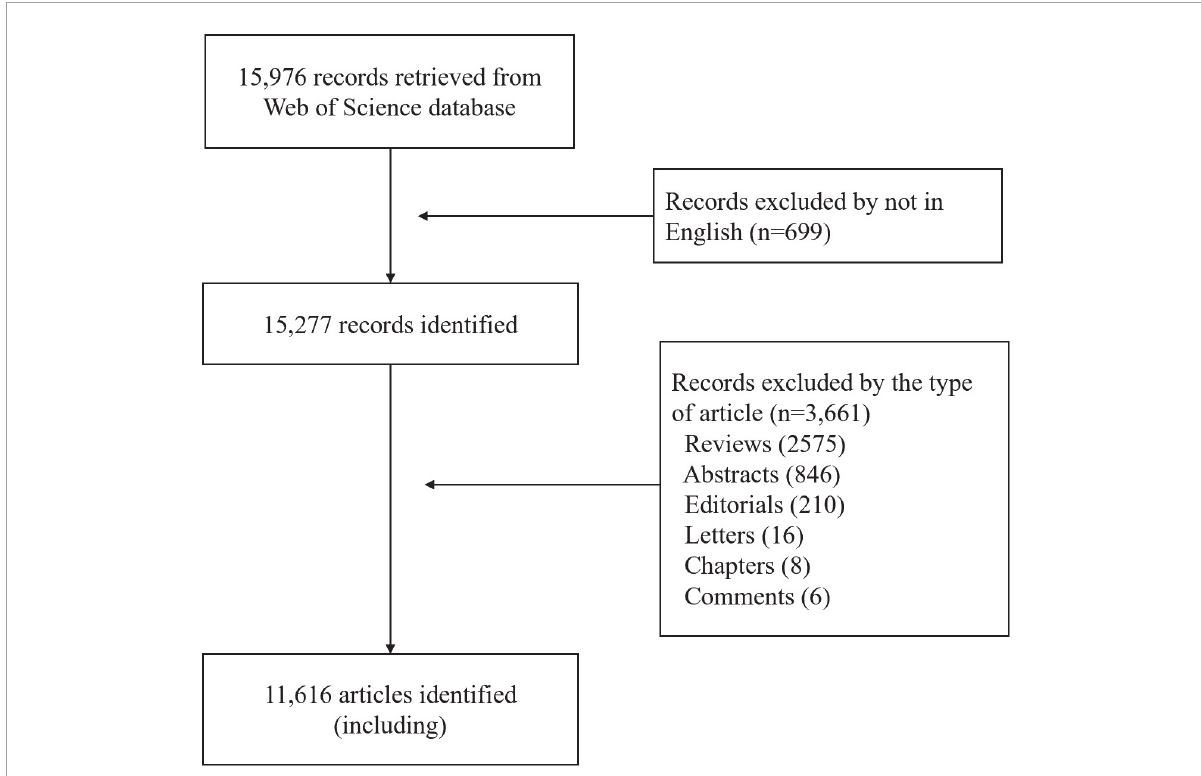
FIGURE1 Flow diagram of study selection of menopausal hormone therapy (MHT)-related research.